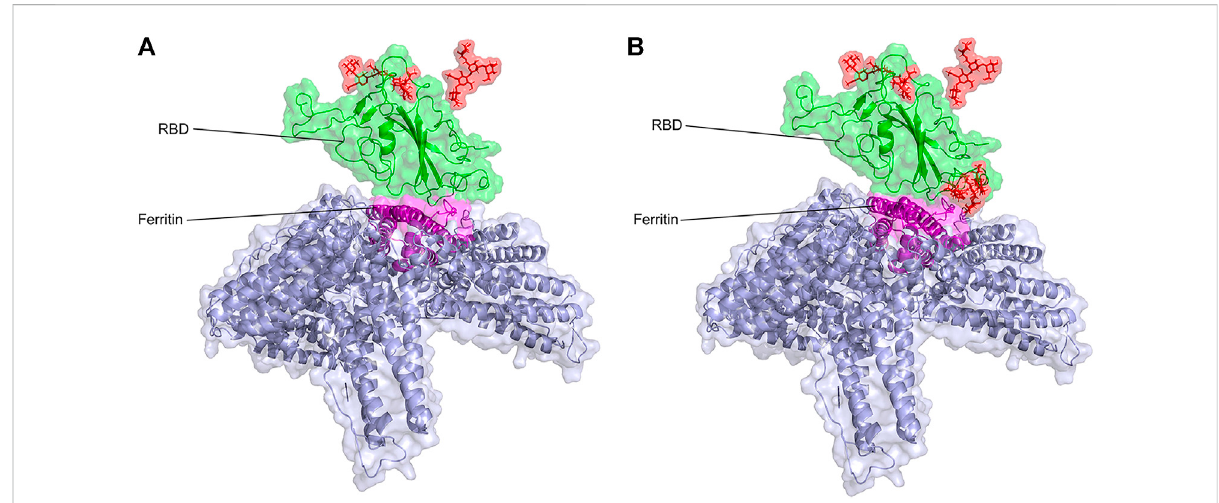
FIGURE 2 Structural presentation of gRBDfN and gmRBDfN systems in (A) and (B), respectively. RBD and ferritin are shown in green and purple, respectively. Ferritin self-assembled units are shown in gray. Glycan chains are shown in red sticks.